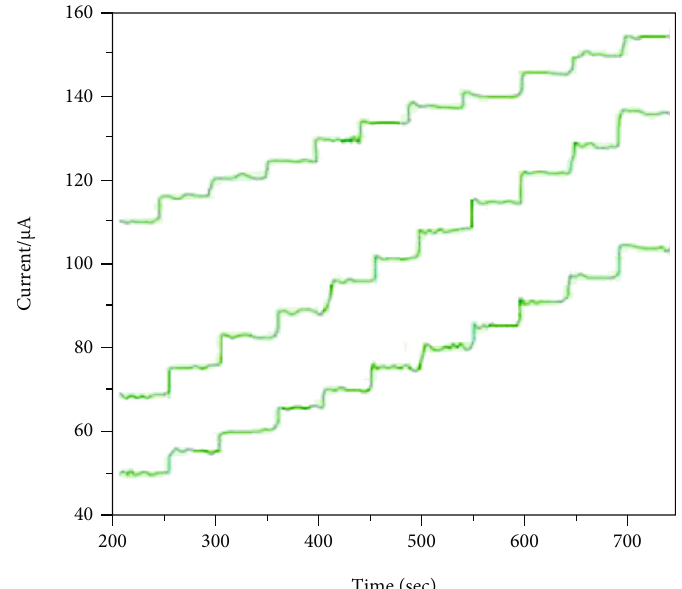
Figure 7: Amperometric measurement of CuO/PVA/GCE biosensor with the addition of each 2 μ M dopamine in 0.1 M of PBS analyzed at 0.1, 0.2, and +0.3